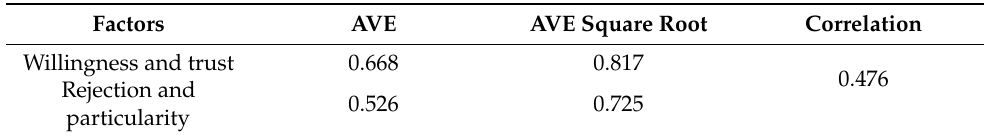
Table 7. Results of examination of discriminant